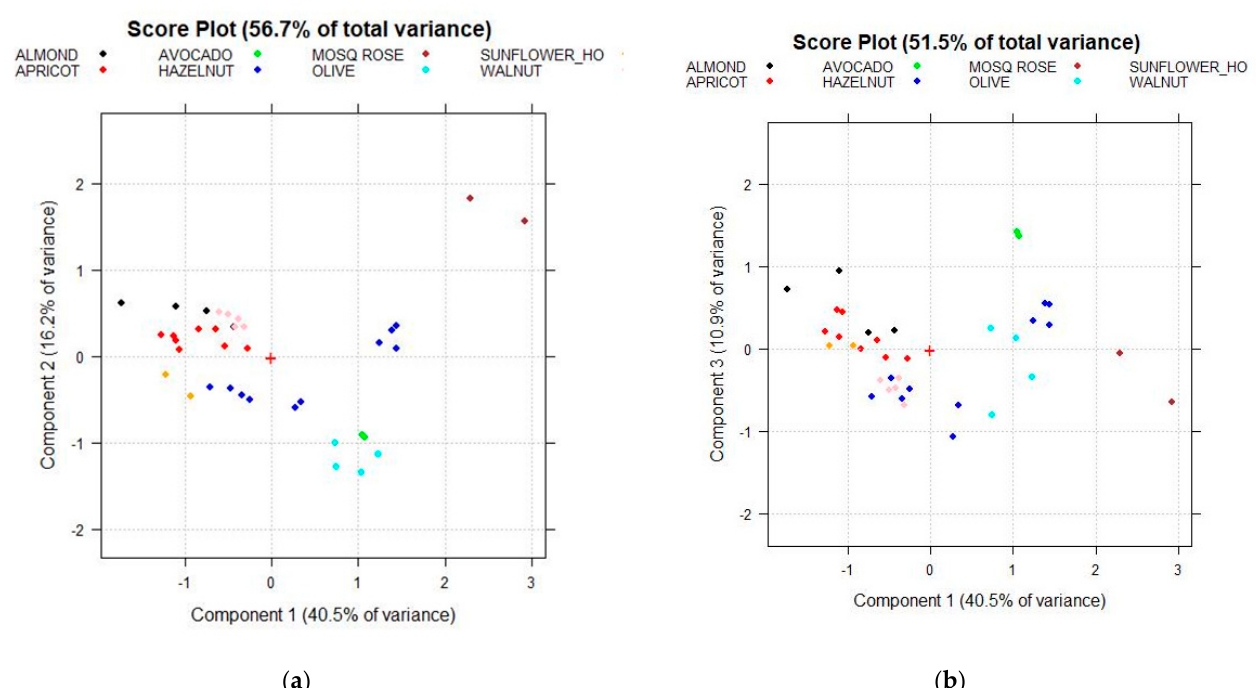
Figure 8. Score plots of the fatty acid methyl esters (FAMEs) composition, coupled to the raw spectral data after standard normal variate (SNV) pretreatment, and the CIELAB descriptors (data matrix H 37,421 ): ( a ) PC1–PC2 Score plot; ( b ) PC1–PC3 Score plot. + sign in the plots correspond to the origin (point 0,0).